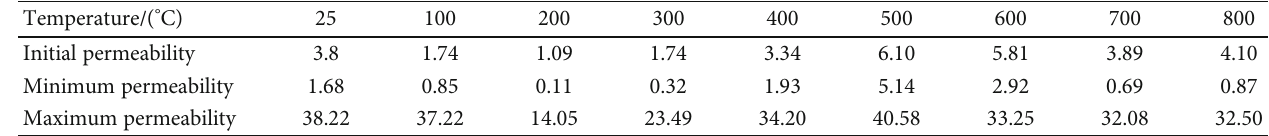
Figure 9: Permeability evolution of the heat-treated sandstone considering di ff erent temperatures. Table 1: Di ff erent permeability of the heat-treated sandstones considering di ff erent temperature. Temperature/( °